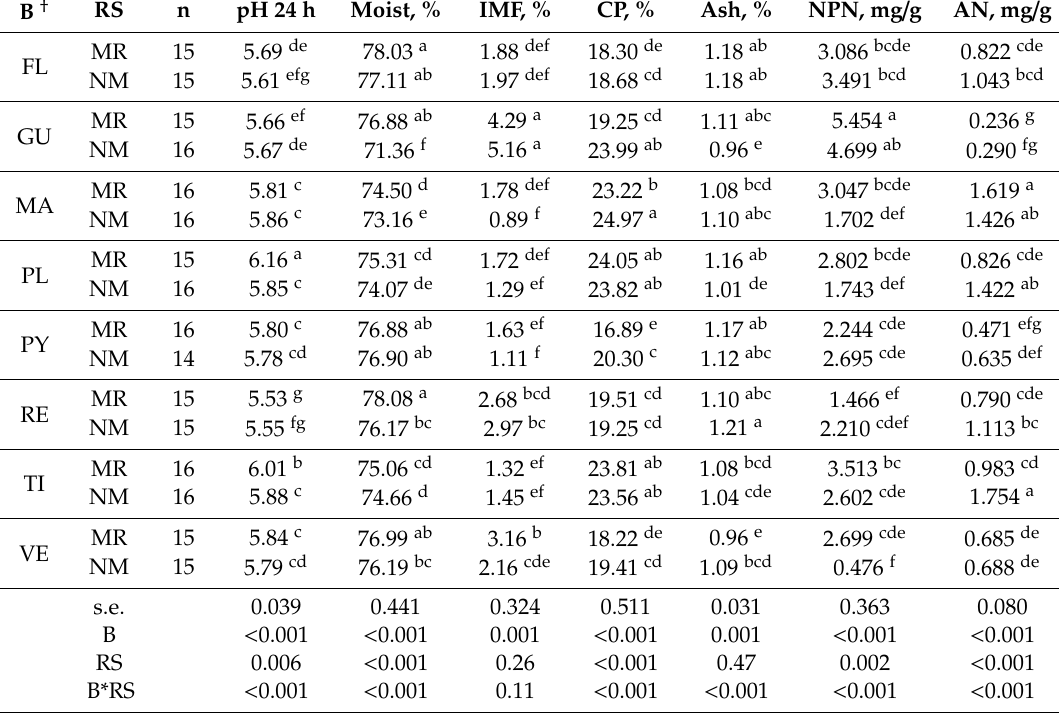
Table 2. Value of pH at 24 h and chemical composition of longissimus thoracis muscle of kids reared with milk replacer (MR) or natural milk from their dams